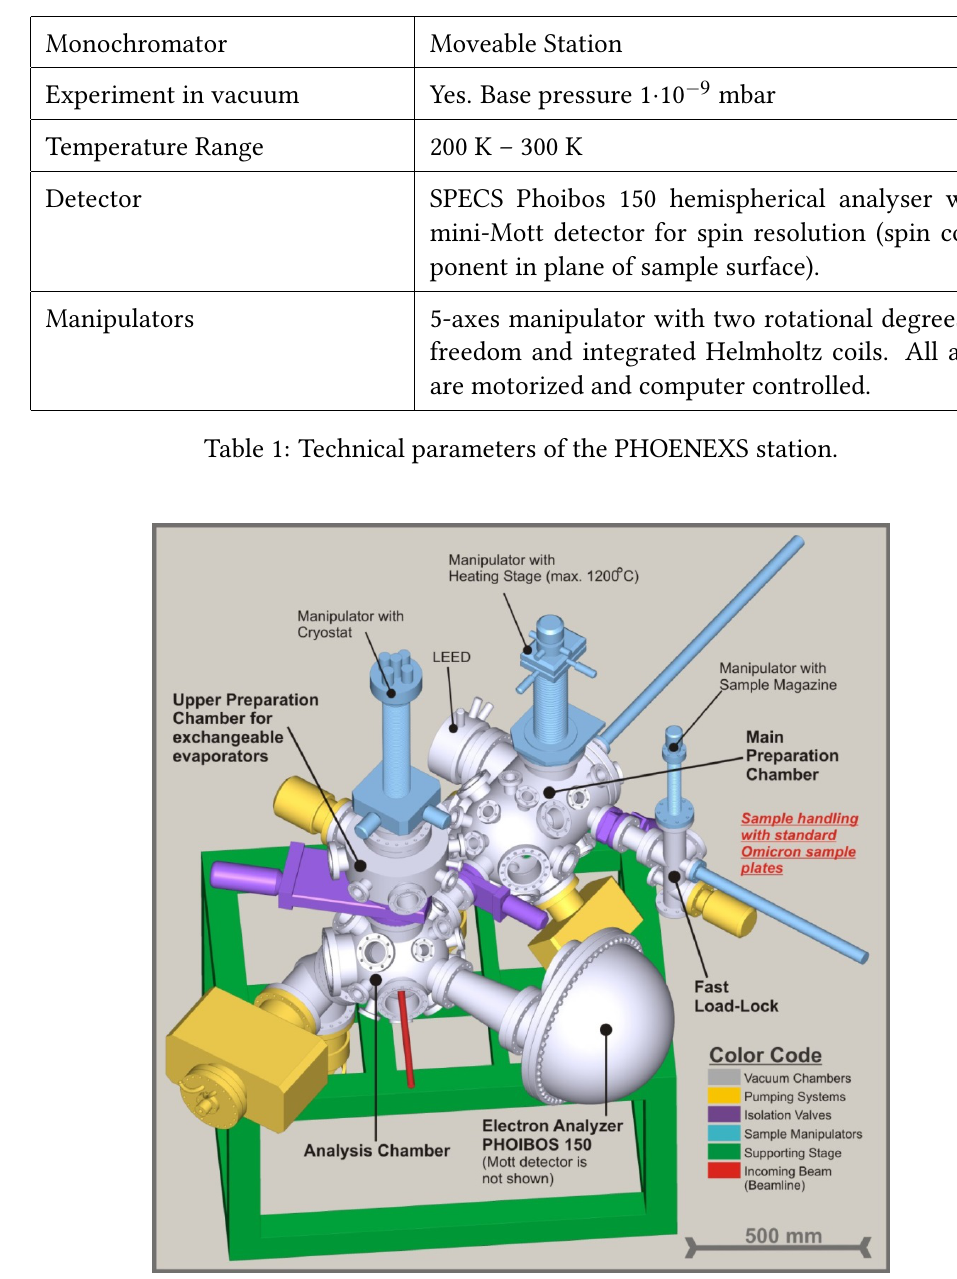
Figure 2: Schematic view of the PHOENEXS station (spin-detector is not